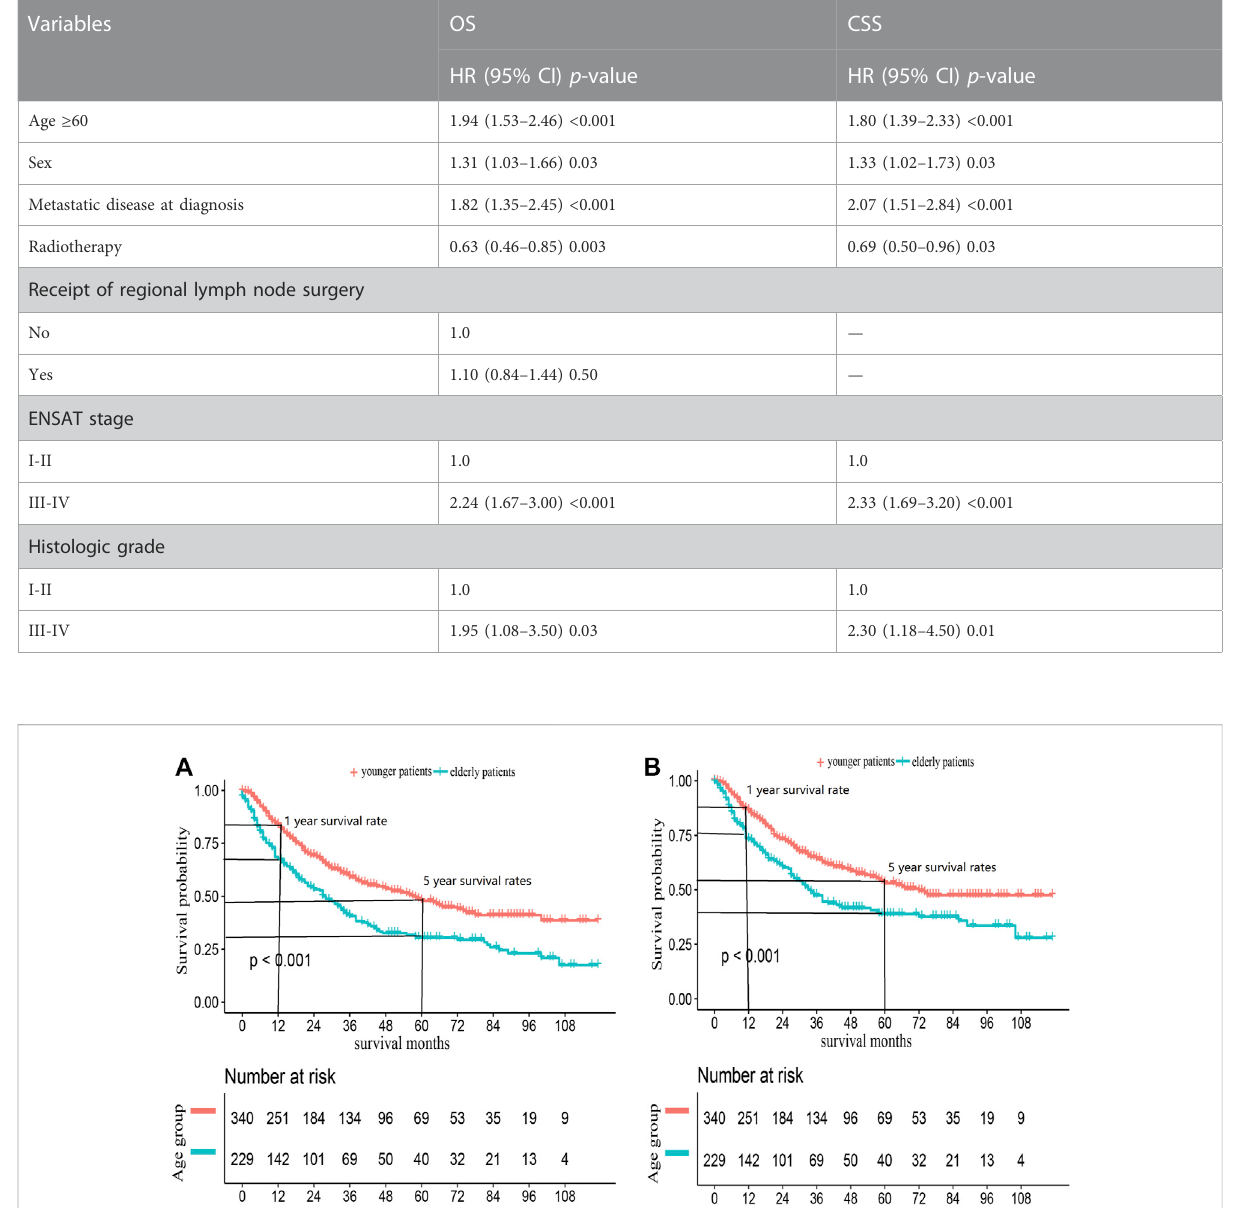
TABLE 4 Subgroup analysis of OS and CSS in patients received surgery by multivariable cox regression.